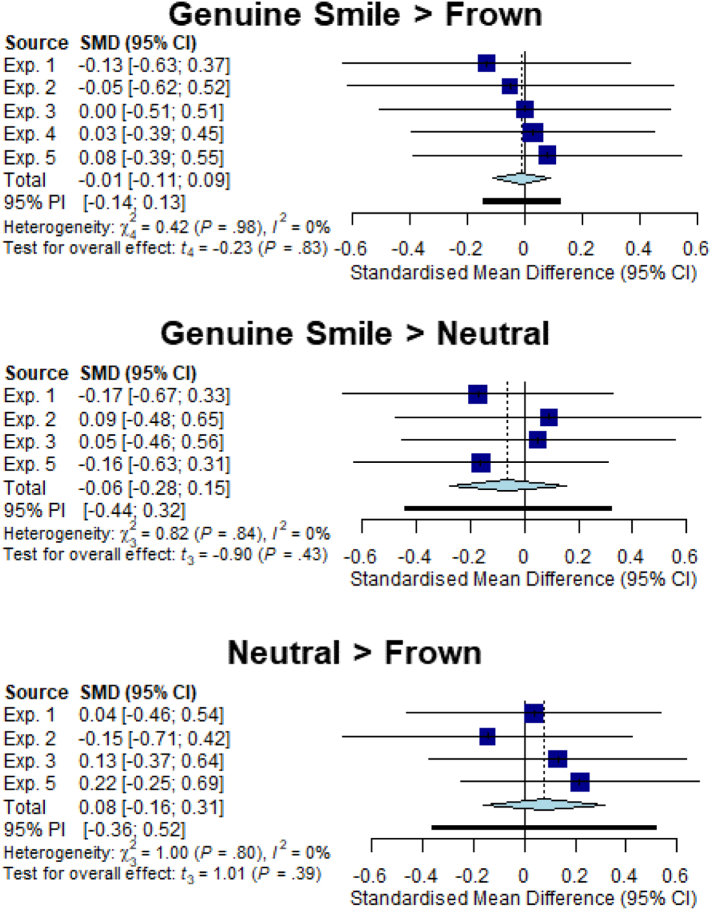
Forest plots of the meta-analyses on the percentage congruency/compatibility effects for the comparisons between the genuine smile, frown and neutral conditions.